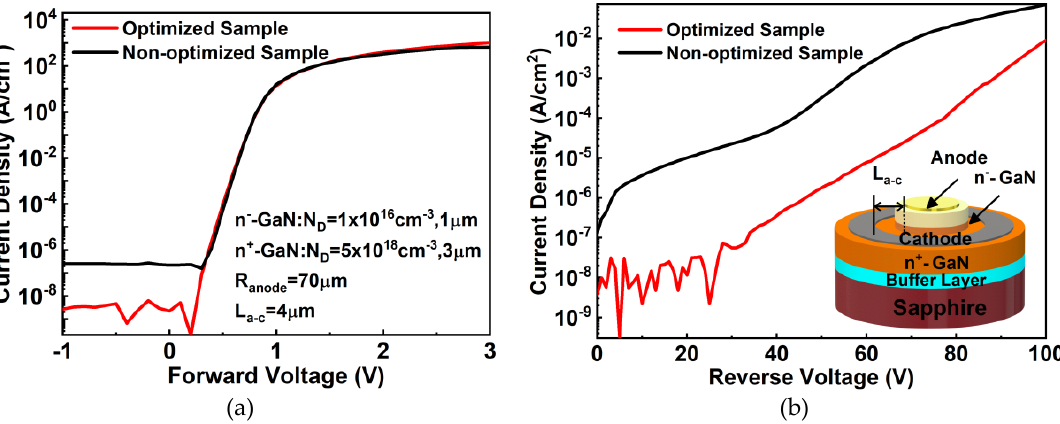
Figure 13. ( a ) Forward and ( b ) reverse I–V characteristics of the optimized and non-optimized quasi-vertical GaN SBDs in this study. The inset of ( b ) shows a 3D schematic of the SBD. R anode and L a-c are the anode radius and the distance between the anode edge and cathode, respectively.